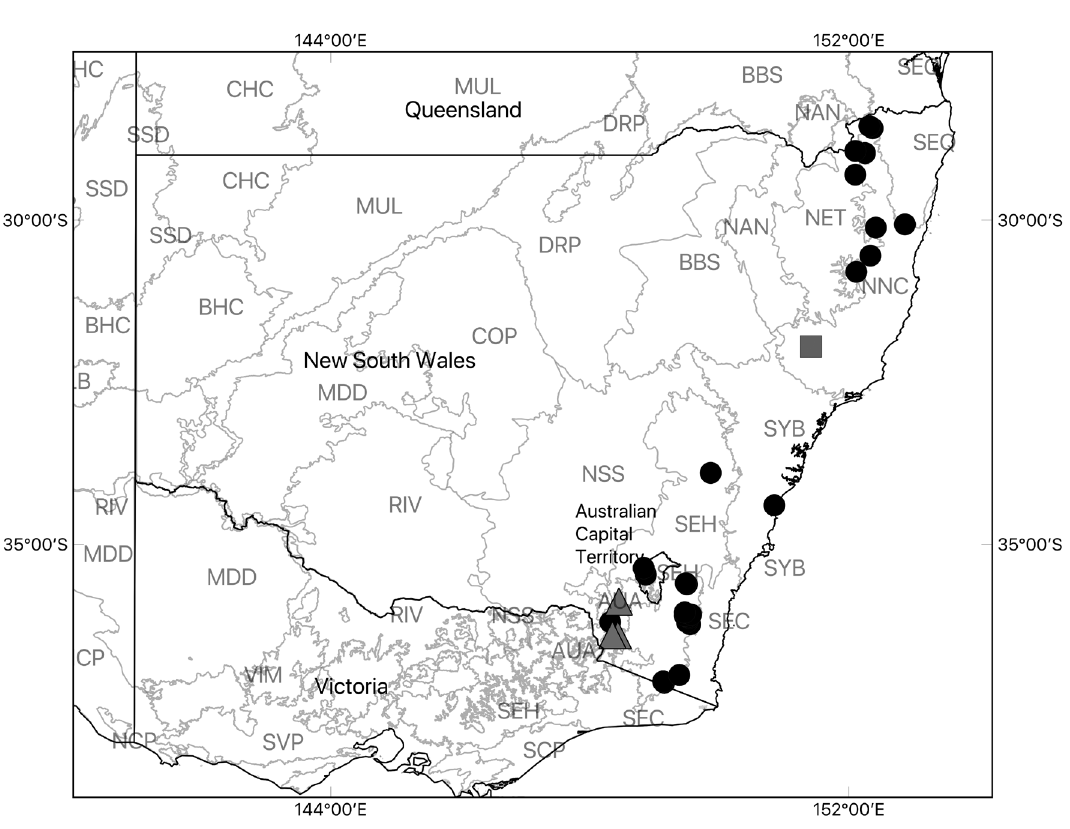
Figure 4. Distribution records of Artoria albopilata (Urquhart, 1893) (full circles), A. alta Framenau, 2004 (grey triangles) and A. barringtonensis sp. n. (grey square) in NSW and ACT. IBRA bioregions with spider records: AUA – Australian Alps; NET – New En- gland Tablelands; NNC – NSW North Coast; SEQ – South East Queensland; SHE – South Eastern Highlands; SYB – Sydney